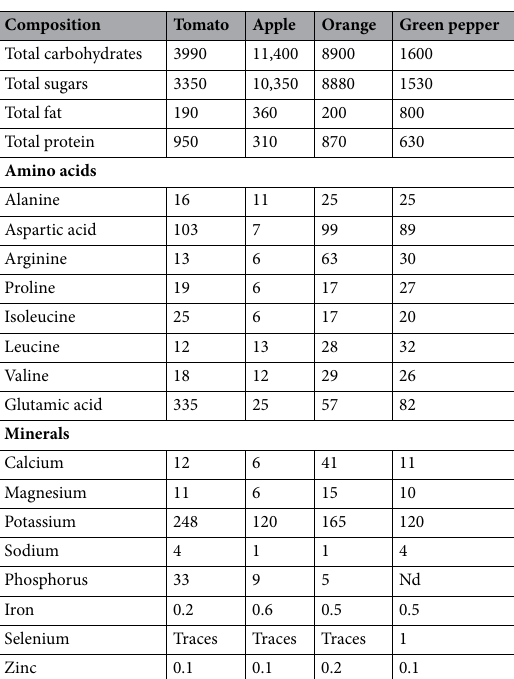
Table 1. Nutritional composition (mg/100 g) of tomato, apple, orange, and green pepper by-products 35